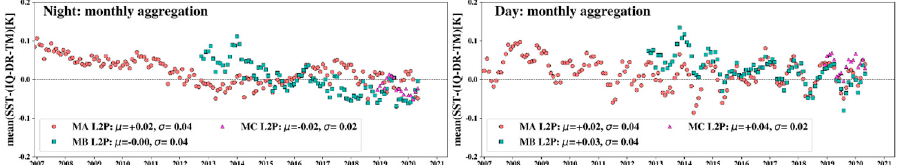
Figure 5. Monthly aggregated GR—(D + TM) SST biases computed with static regression coefficients: ( left ): night; ( right ) day.